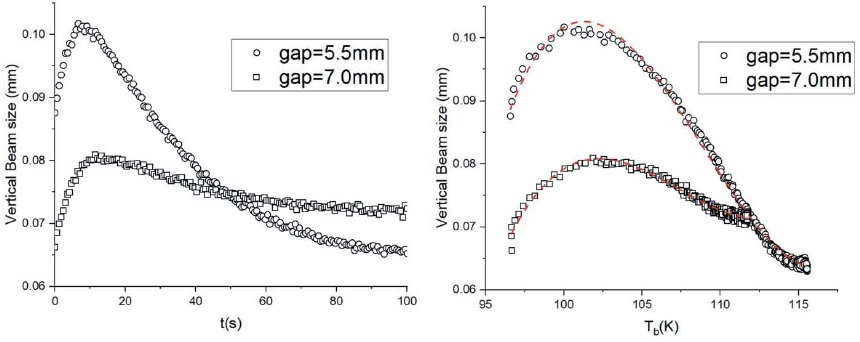
Figure 9 Vertical beam size versus time (left) and measured crystal temperature (right) for two gap values at E = 8.0 keV. The red dashed lines in the right-hand plot show the third-order polynomial fit of the data [equation (21)].